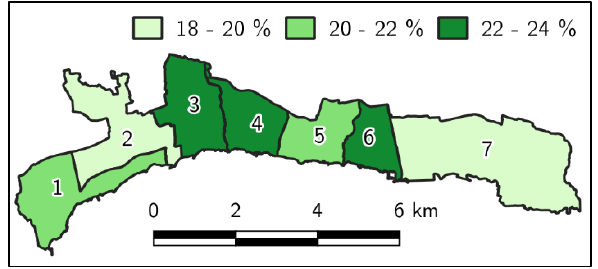
Figure 6. Urban area of the settlements colored by corresponding average GVI value (settlement numbers match to those in Table 3)